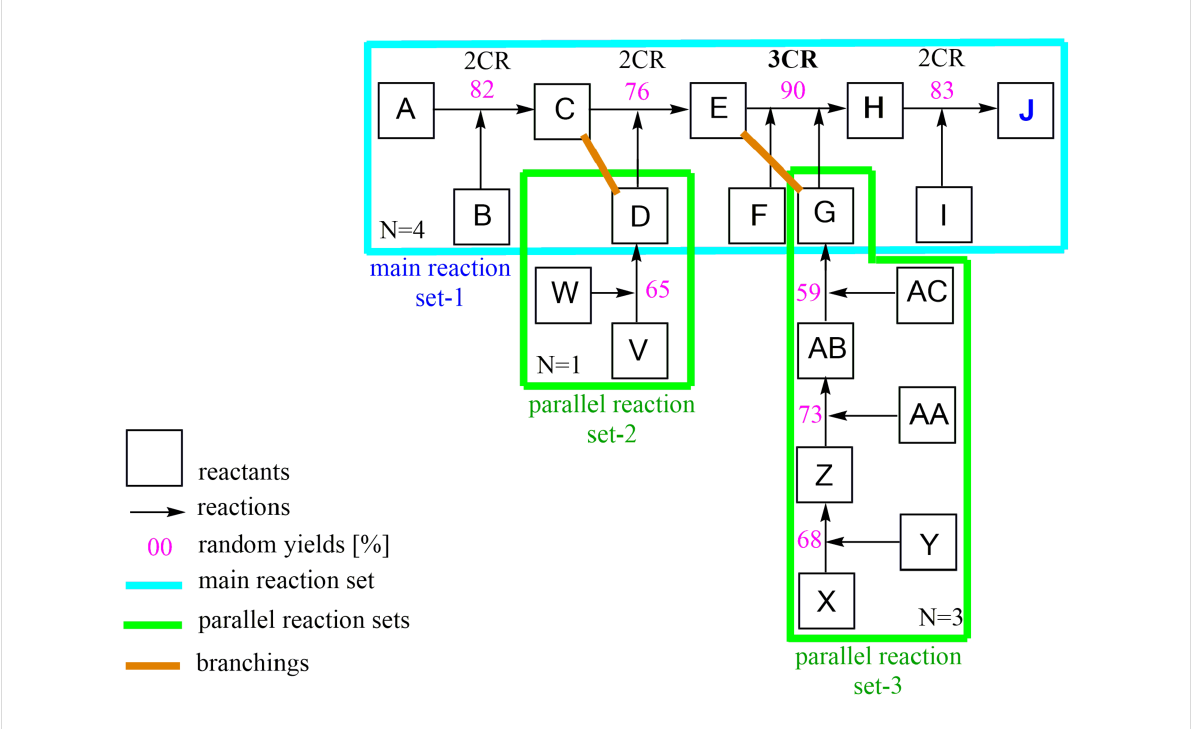
Scheme 3: Section A–J case study of Scheme 2 with operations of y oa